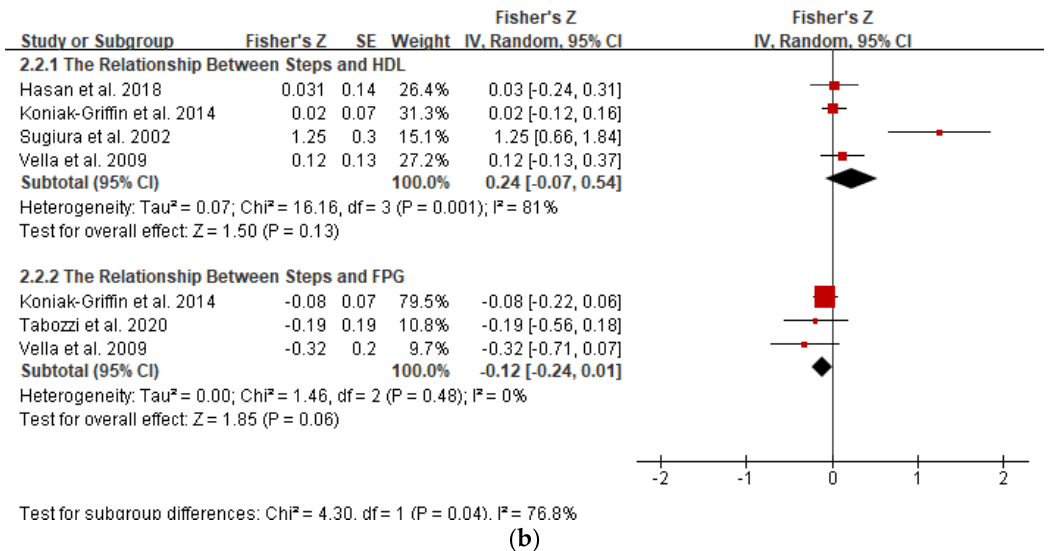
Figure 2. Forest plot of correlation between physical activity and cardiometabolic health outcomes. Overall pooled correlation for random effects model represented by black diamond. ( a ) The relationship between MVPA and cardiometabolic indicators. Note: DBP, diastolic blood pressure; FPG, fasting glucose; HDL, high-density lipoprotein; LDL, low-density lipoprotein; MVPA, moderate-to-vigorous-intensity physical activity; SBP, systolic blood pressure; TC, total-cholesterol; TG, triglyceride. ( b ) The relationship between steps and cardiometabolic indicators. Note: FPG, fasting glucose; HDL, high-density lipoprotein.